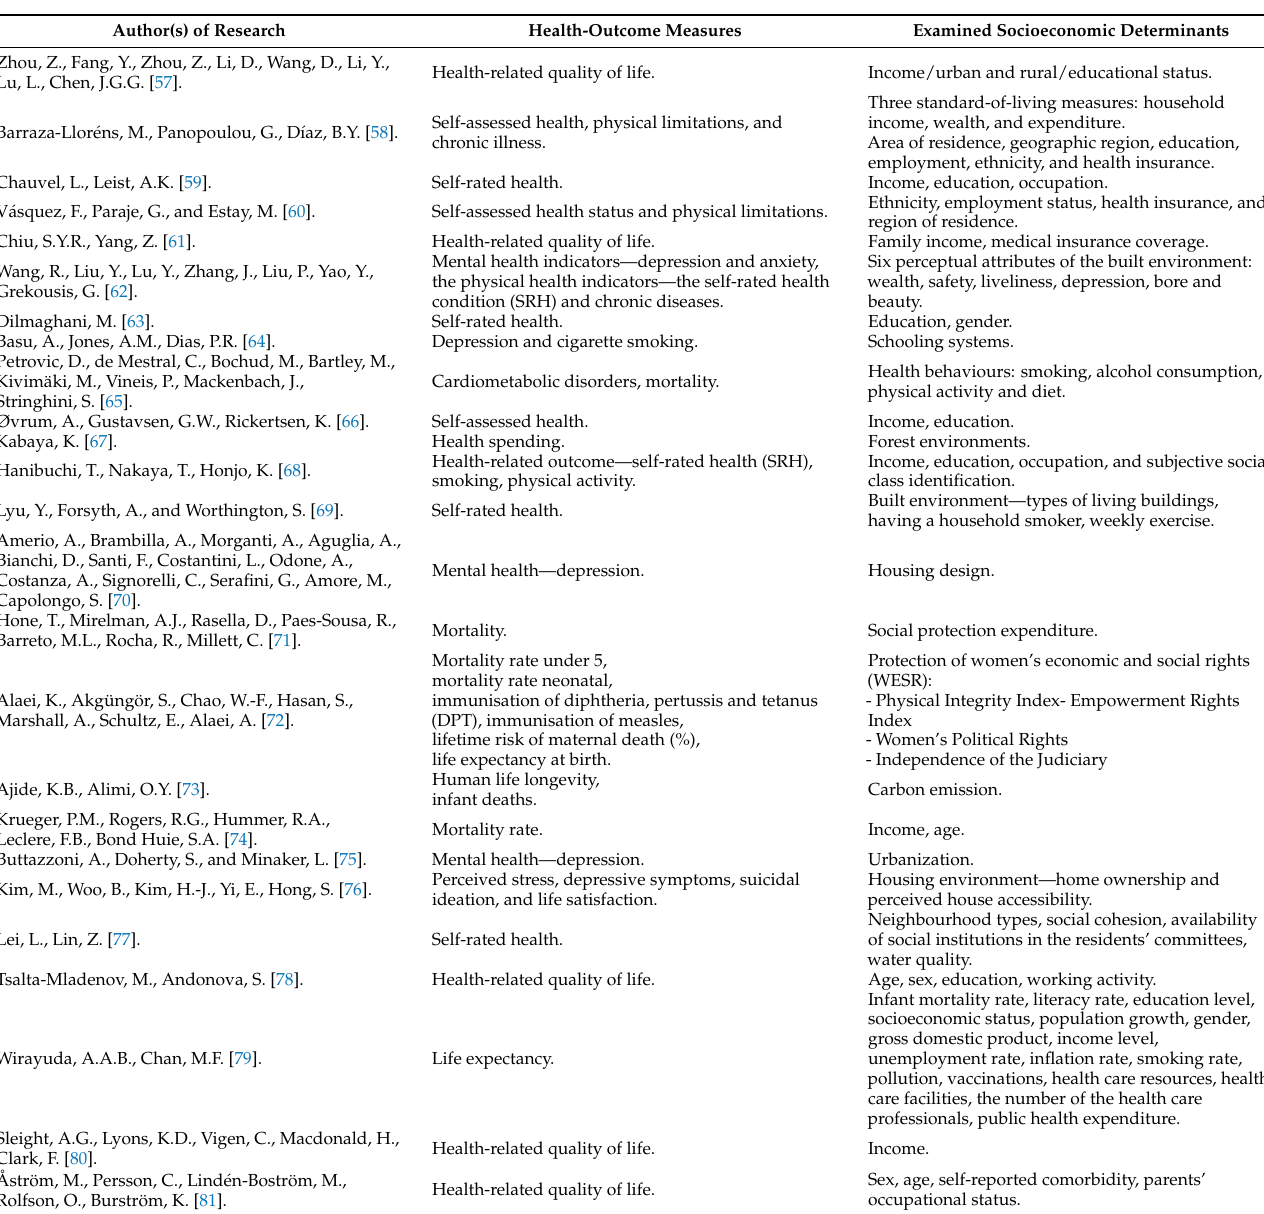
Table 1. Selected existing research on the socioeconomic determinants of